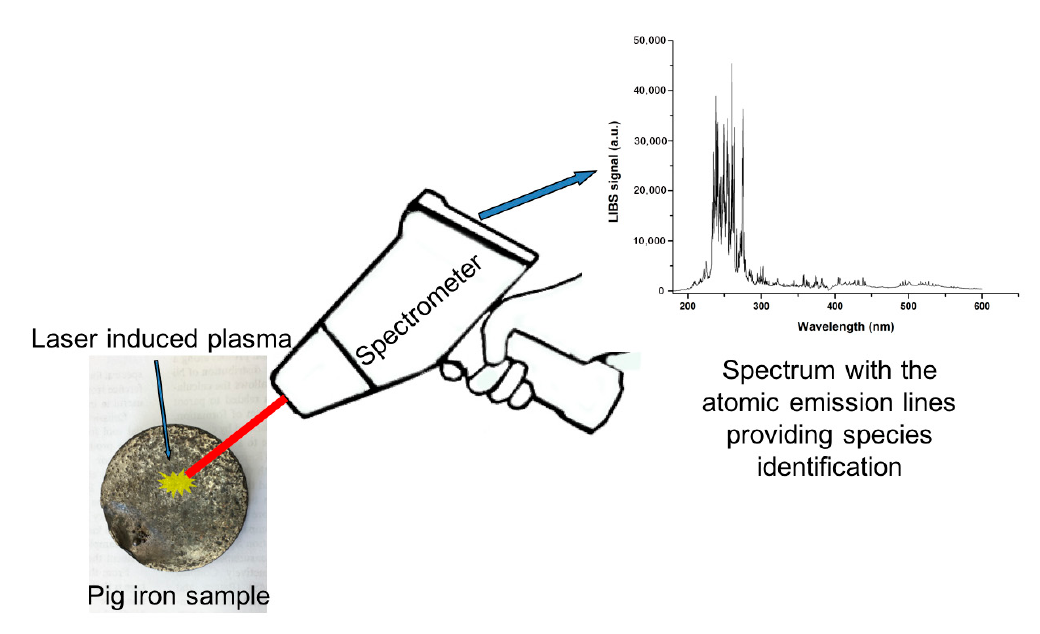
Figure 1. Sketch representing the laser-induced breakdown spectroscopy ( h LIBS) analysis.